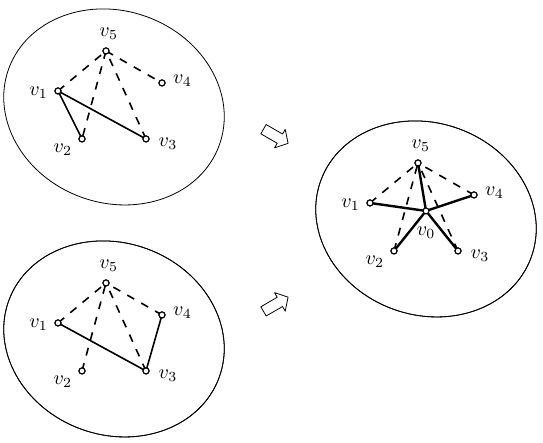
Figure 4: The double V-replacement that creates a vertex v 0 of type ( (cid:63) ). The dashed lines represent the edges in cl ( E ( G − v 0 )) ∩ K ( N G ( v 0 )) , which form a star on five vertices centered on v 5